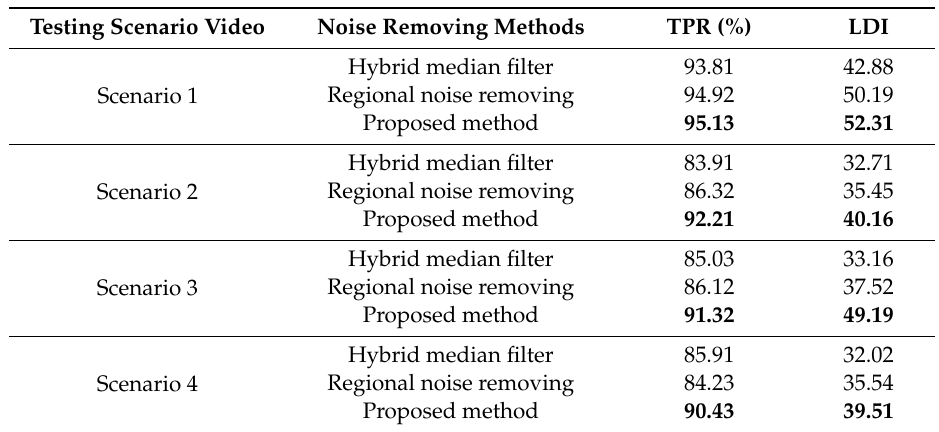
Table 4. Comparative results of noise removing methods.